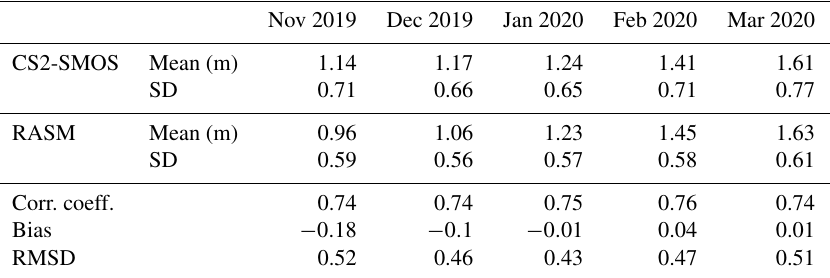
Table 1. Comparison between the CryoSat2/SMOS satellite data and RASM simulations in the mean (Mean) and standard deviation (SD) of the sea ice thickness from November 2019 until March 2020, along with the corresponding correlation, bias and root-mean-square error (RMSD)